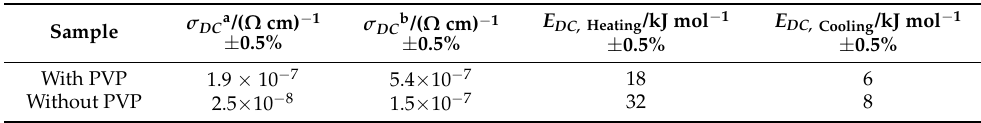
Figure 12. ( a ) Temperature dependence of DC conductivity (log( σ DC ) vs. 1000/T) for FAPI perovskite thin film on ZNR/glass substrate with and without PVP additive and ( b ) DC-conductivity at 30 ◦ C before heating, at 100 ◦ C and after cooling at 30 ◦ C (solid lines in Figure 12b). The observed increase in conductivity was one order of magnitude in the case of the film without the PVP additive and the half order of magnitude for the sample with the PVP additive. Second, in both heating and cooling runs, FAPI perovskite thin film with PVP additive shows higher electrical conductivity than its counterpart. Table 2. The DC conductivity, σ DC , and activation energy, E DC for FAPI thin films with and without PVP polymer on ZNR/glass